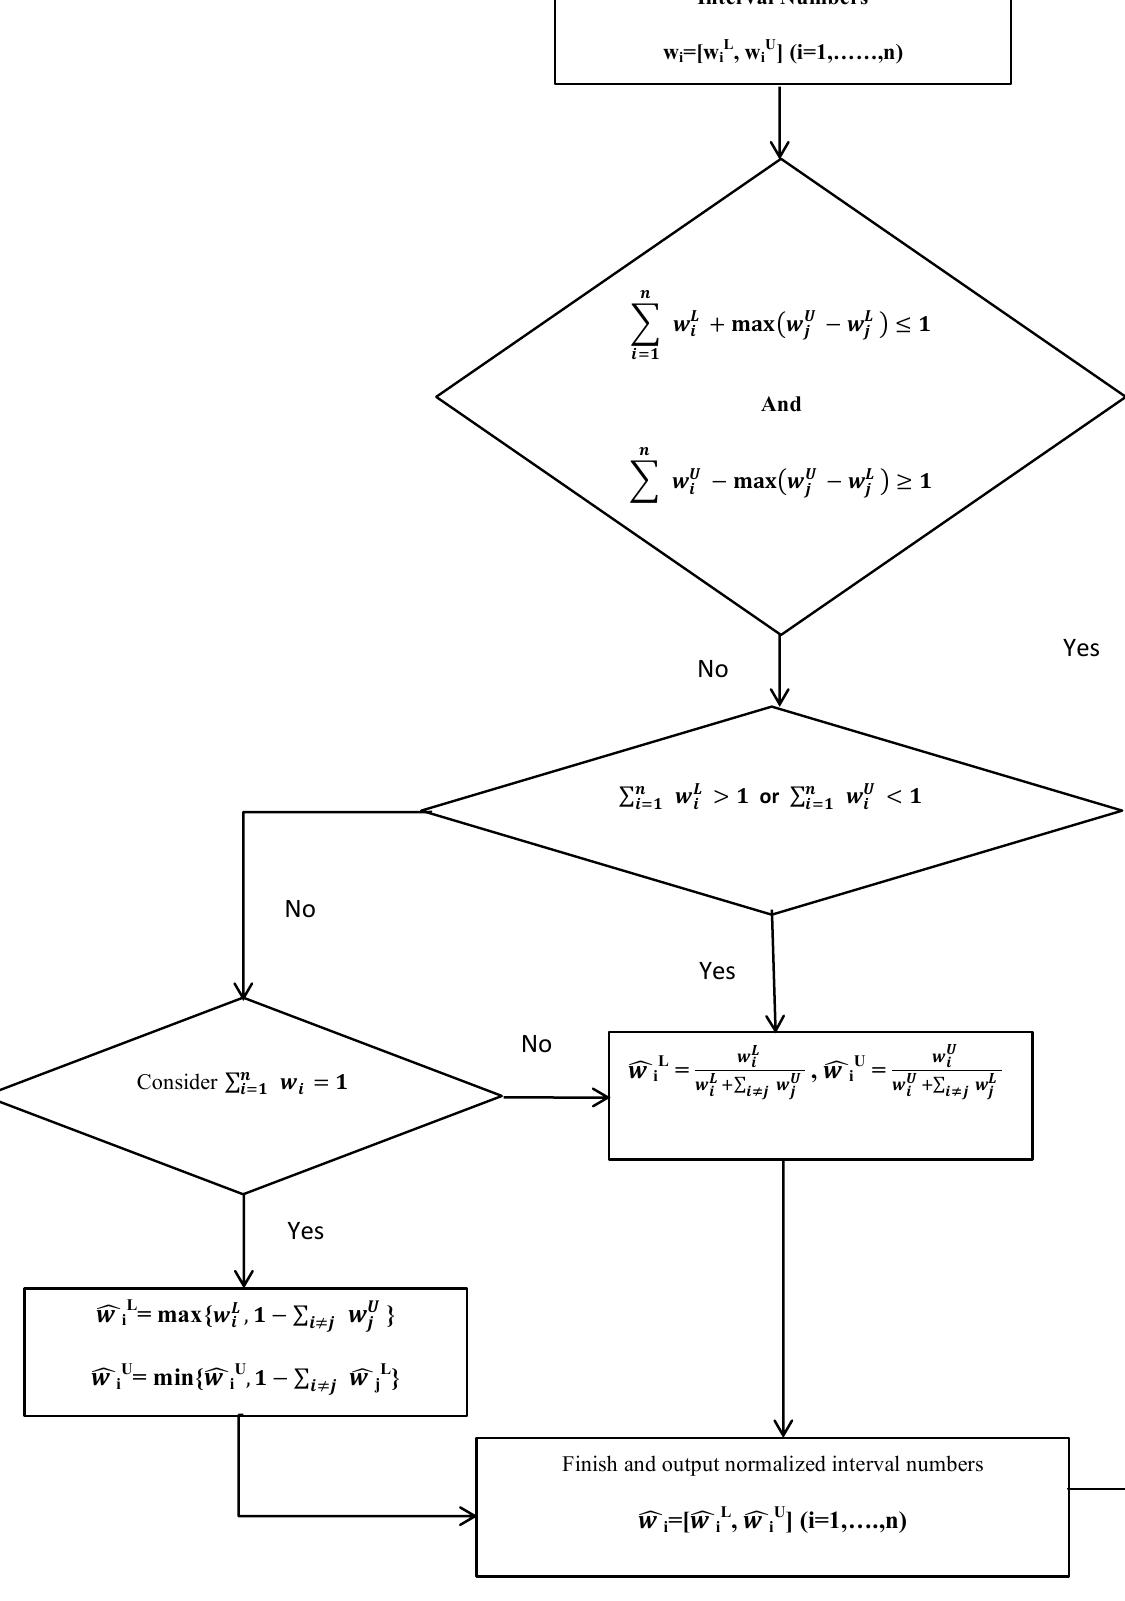
Figure2. Normalization of Interval Numbers (Wang and Elhang.,